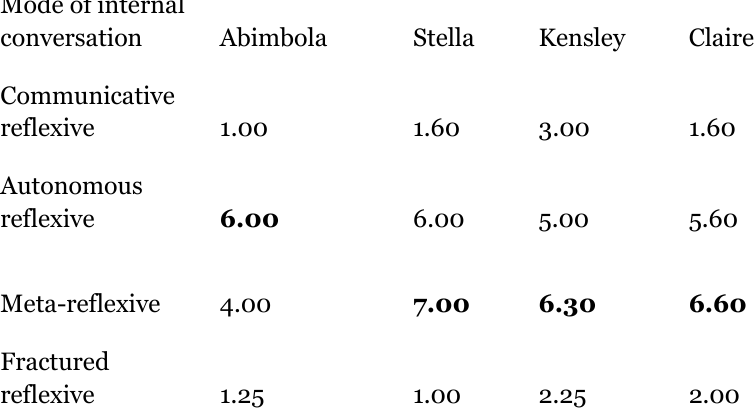
Mode of internal